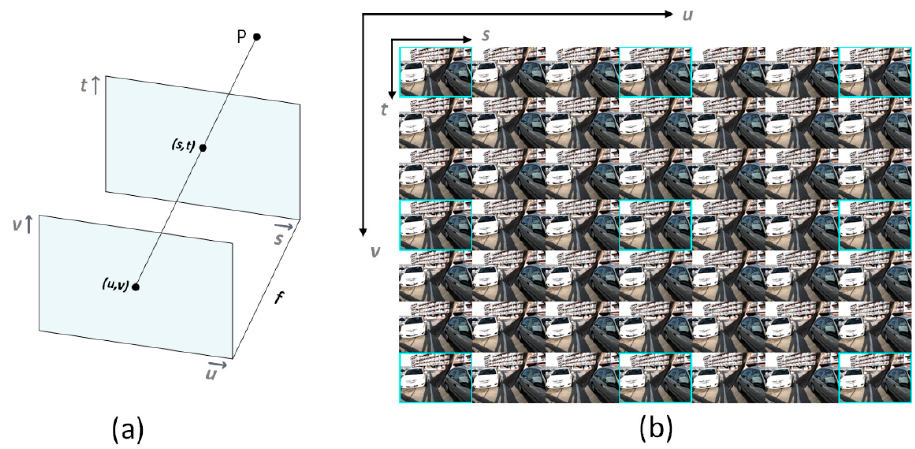
Figure 2. Four-dimensional LF parameterization and visualization. ( a ) Two-plane parameterization of LF where the incident ray from a 3D point space intersects with the first plane at angular position ( u , v ) and with the second plane at spatial position ( s , t ). ( b ) The 4D LF can be visualized as a 2D array of Sub-Aperture Images (SAI). In our method, 3 × 3 views bordered in light blue are used to reconstruct 7 × 7